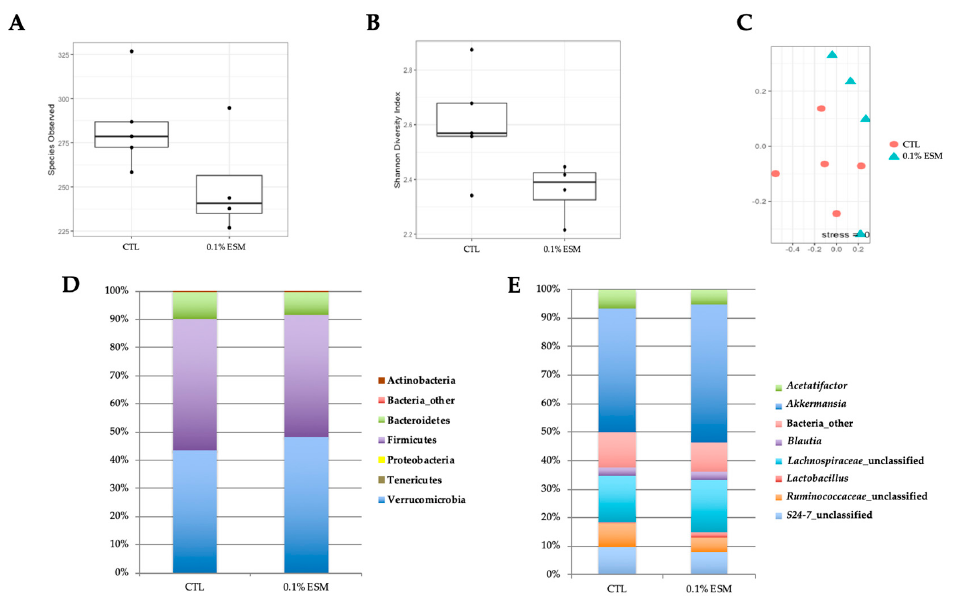
Figure 3. E ff ects of ESM on gut microbiota. Number of species observed ( A ) and the Shannon index ( B ) as measures of alpha diversity from individual mice from di ff erent cages ( n = 4–5 per group). The Jaccard index ( C ) was calculated as a beta diversity metric ( n = 4–5 per group). Mean relative abundance for select phyla ( D ) and genera ( E ) from both groups of